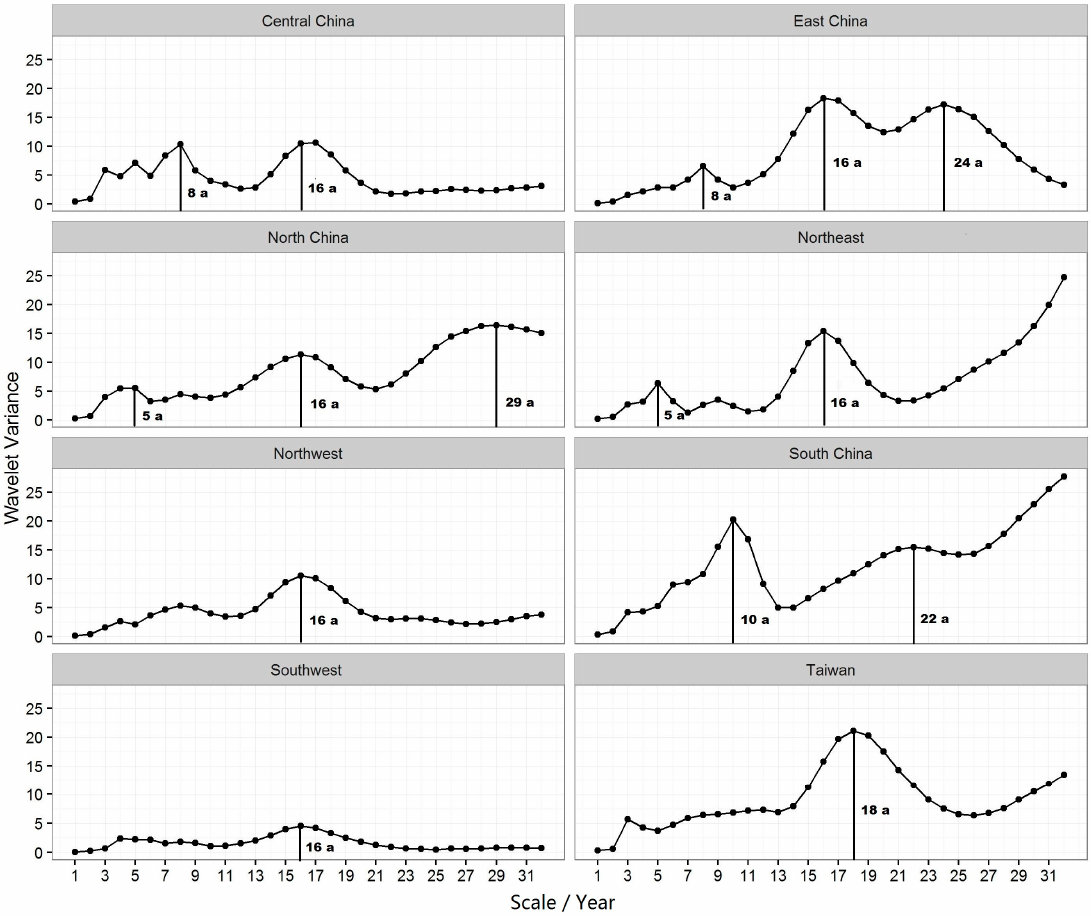
Figure 8. Variance of Morlet wavelet transform coefficients for SPI time series in east China, north China, northeast, northwest, south China, southwest, and Taiwan from 1961–2014.